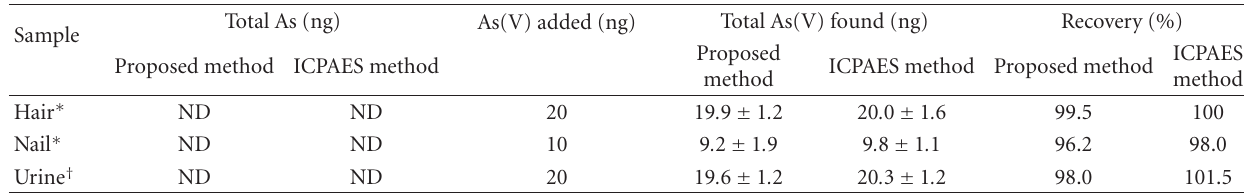
Table 4: Determination of arsenic in biological samples.